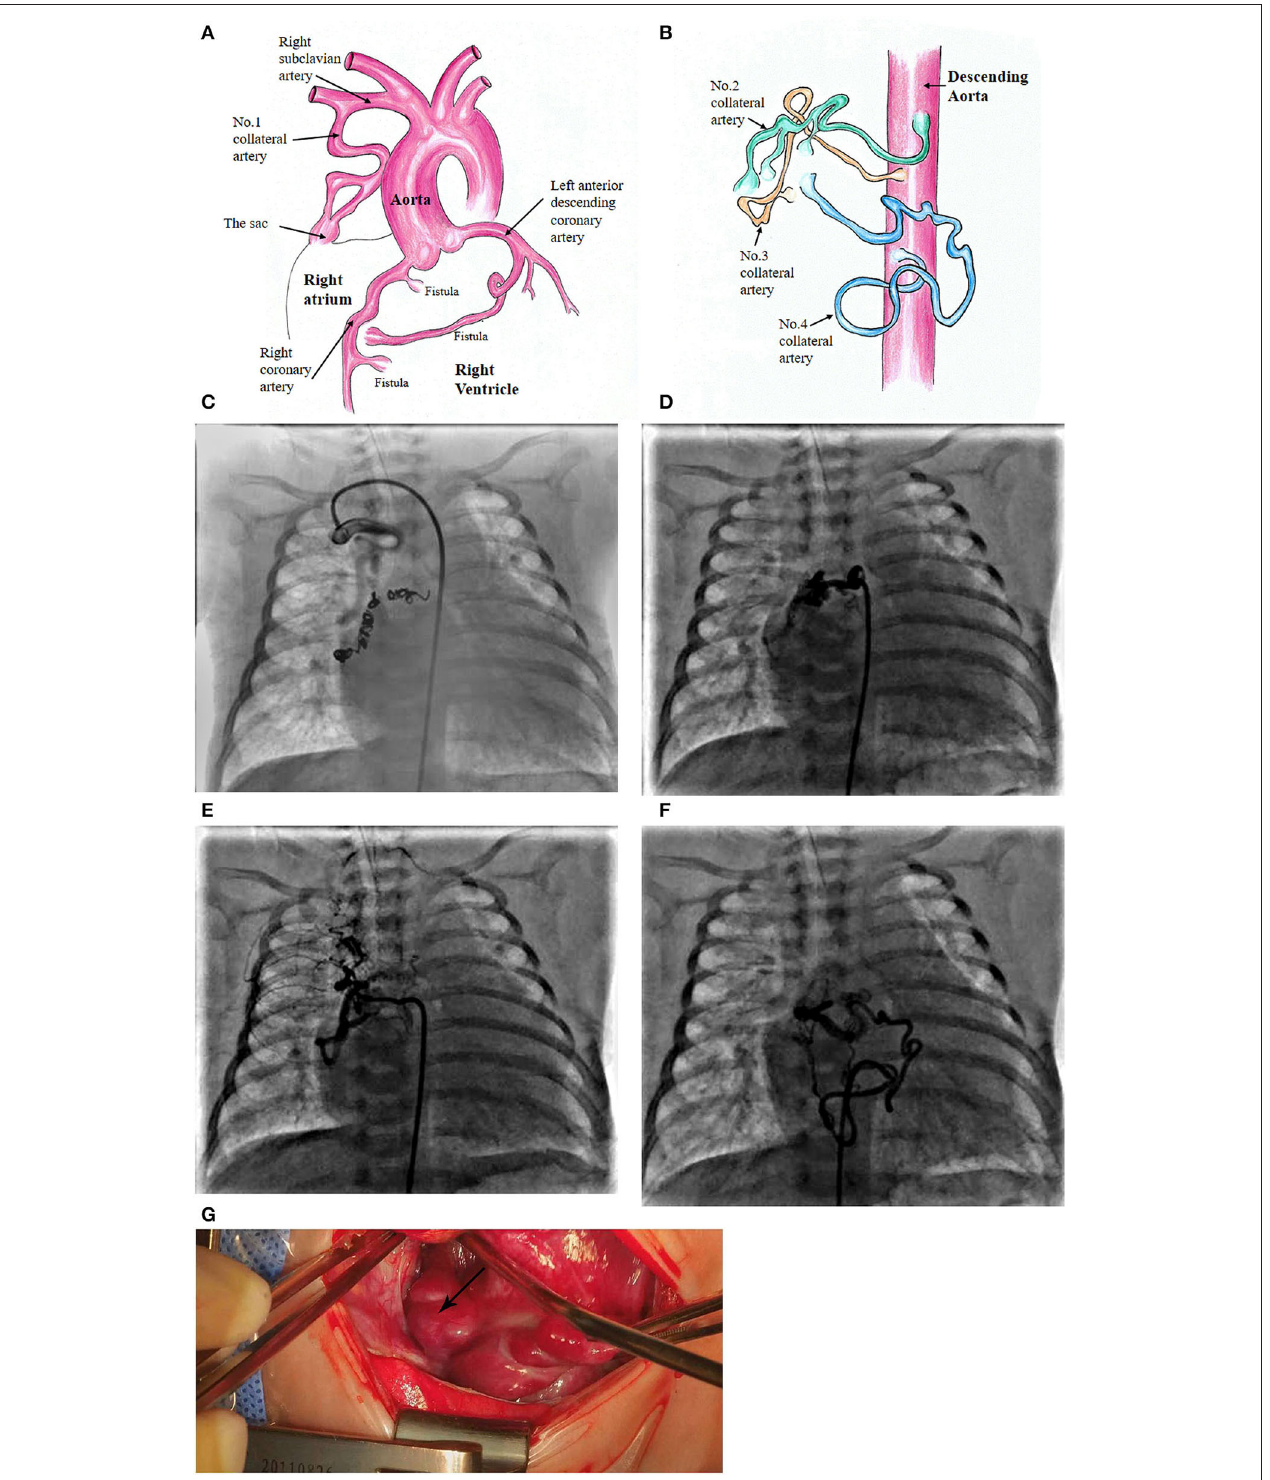
FIGURE 1 | Schematic diagram of the patient’s diagnosis of 3 coronary artery fistulas to the right atrium and right ventricle, respectively (A) . Four collateral arteries draining through a sac to the top of the right atrium (A,B) . Super-selective angiogram shows the following collaterals terminating to the sac and then to the right atrium. No. 1 collateral artery originating from the right subclavian artery (C) . No. 2 at the level of the 6th thoracic vertebra (D) . No. 3 originating from the descending aorta (E) . No. 4 located at the lower edge of the 9th thoracic vertebra (F) . Surgical image of the sac at the top of the right atrium (G) .